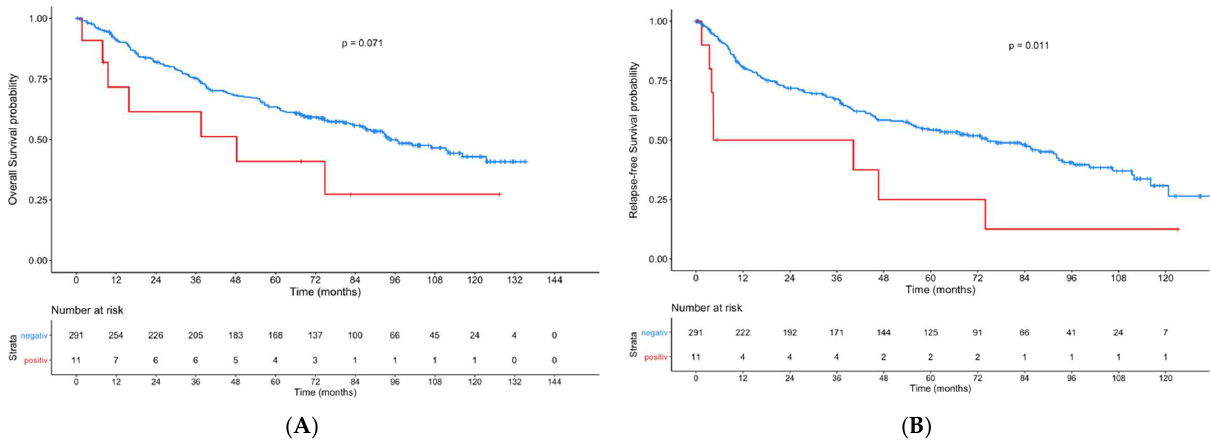
Figure 2. Kaplan–Meier curves showing overall survival ( A ) and recurrence-free-survival ( B ) for patients with ERα-positive primary tumors compared to patients with ERα-negative tumors.